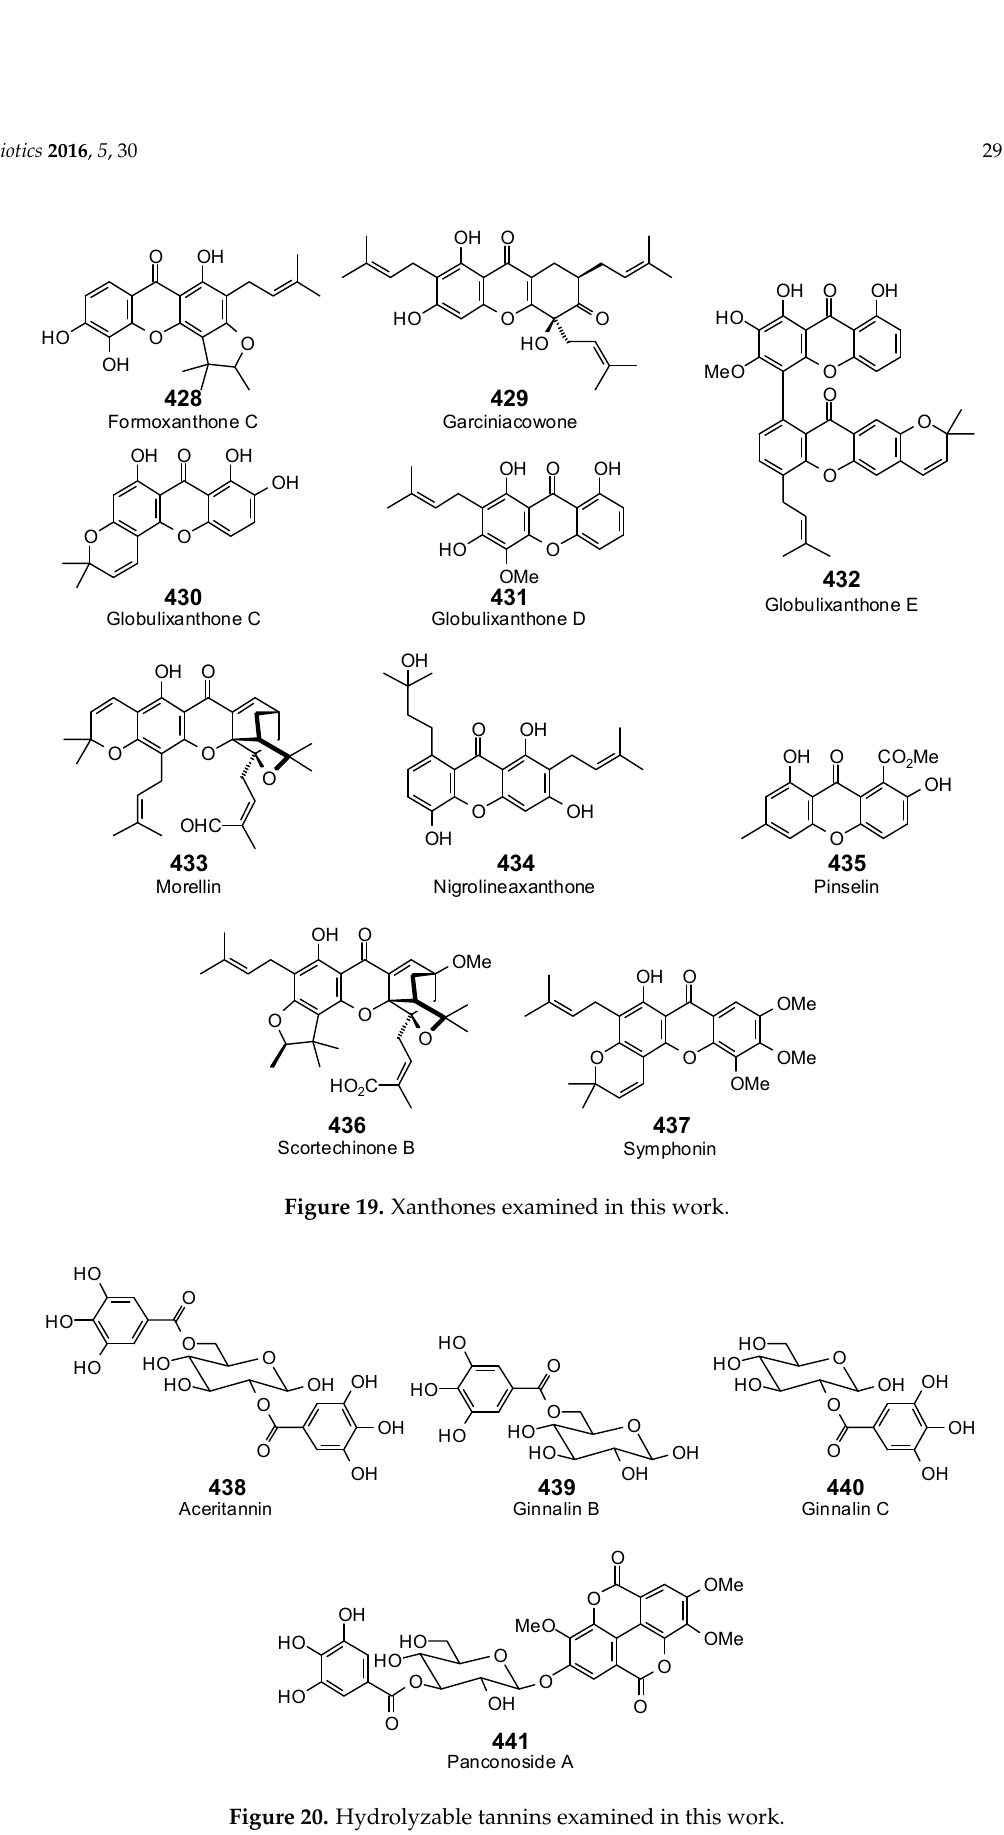
Figure 20. Hydrolyzable tannins examined in this work.